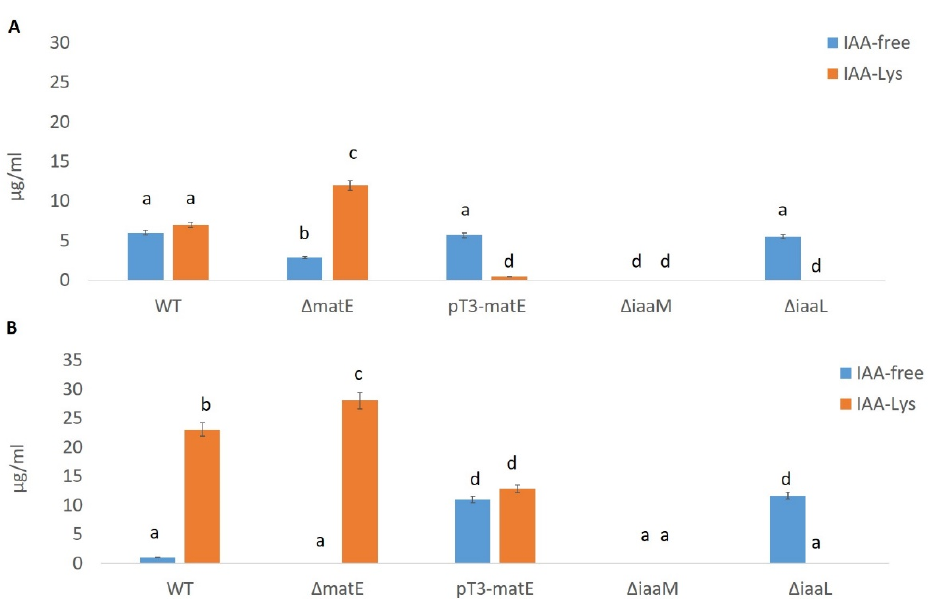
Figure 7. IAA in vitro production by the wild-type Psn23 (WT) and its mutants ∆ matE , pT3 -matE , ∆ iaaM , and ∆ iaaL. After 24 h ( A ) and 48 h ( B ) of in vitro growth on MM supplemented with Trp, free IAA and IAA-Lys were quantified in the bacterial supernatants by HPLC–FLD. Data are averages of triplicates ± standard deviation (SD). Different letters indicate significant differences among means of mutants at p < 0.05, according to Tukey’s test.